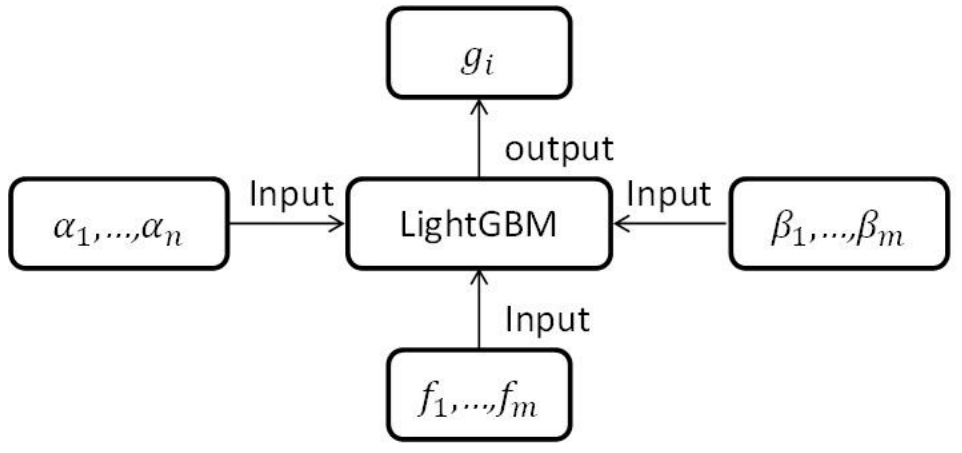
Figure 2. Framework for LightGBM.